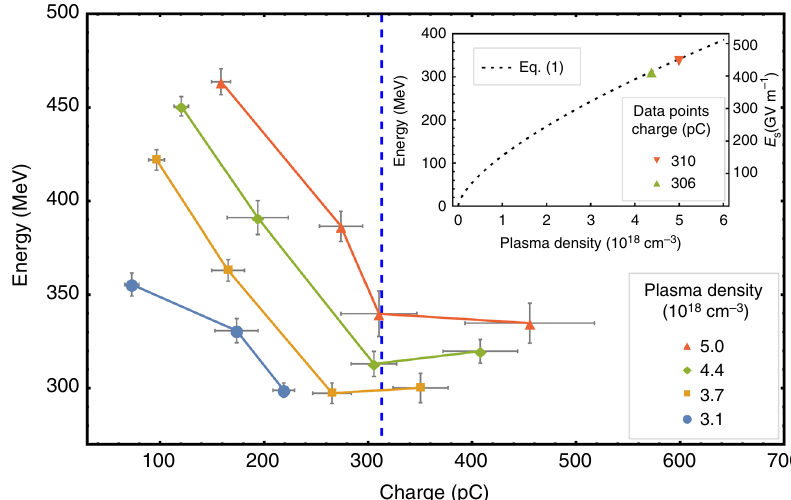
Fig. 2 Electron energy dependency on both charge and plasma density. Connected data points show a set of equal plasma density, increasing charge with increasing nitrogen doping (see Supplementary Fig. 5). Electron energy is the E max and charge within the FWHM of the energy peak is displayed. The error bars represent the s.e.m. The estimated optimal loaded charge according to Eq. (1) of 313 pC is indicated by the dashed vertical line . The inset shows the predicted acceleration gradient ( right axis ) according to Eq. (1) (dotted line) for a laser peak power P = 64 TW (equivalent to the experiment) under optimal loading conditions. The left axis shows the predicted electron energy, taking 0.8 mm effective acceleration distance. Data points represent measured data points at the predicted optimum